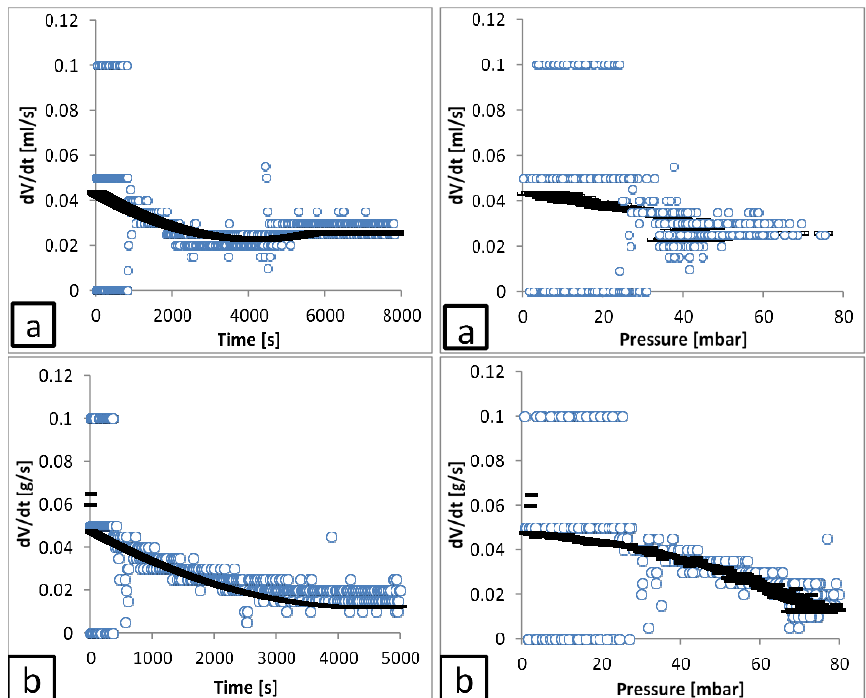
Figure 9. Filtration flow rate with time and pressure for calcium carbonate using 5 rpm pump speed, ( a ) 0.09 v / v and ( b ) 0.21 v / v (2nd polynomial equation, Equation (6) ( ̶ ) and central difference ( ○ ), Equation (8)).